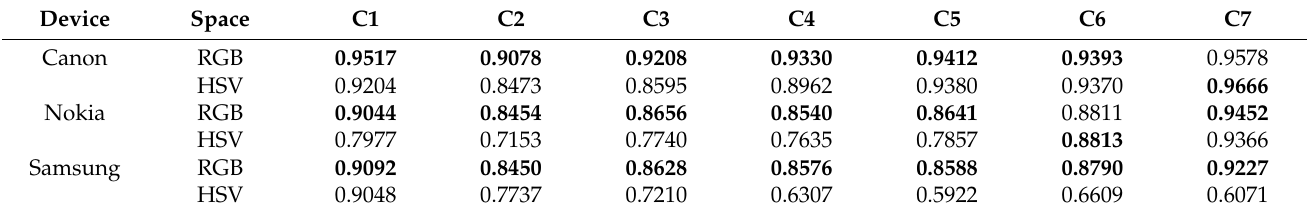
Table 4. Comparison between the RGB and HSV approaches to obtain hue.